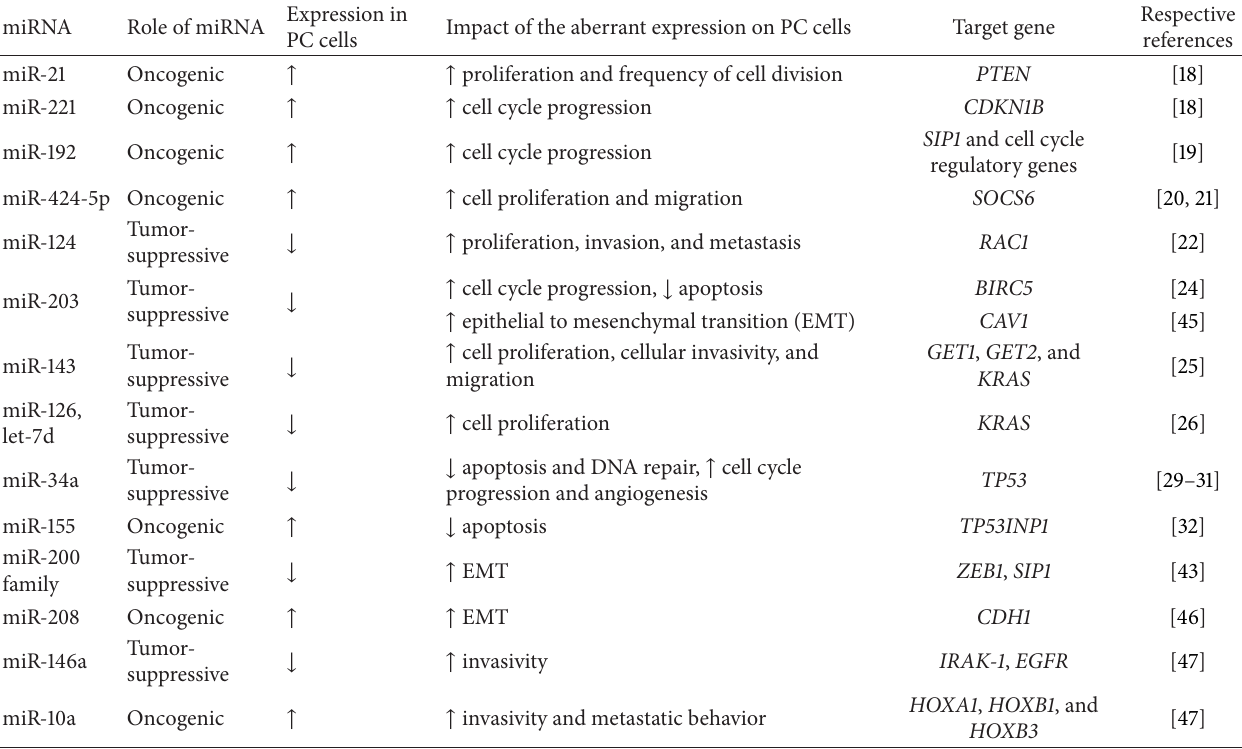
Table 1: miRNAs involved in processes of malignant transformation of pancreatic tissue ( ↓ = reduced, ↑ = increased).